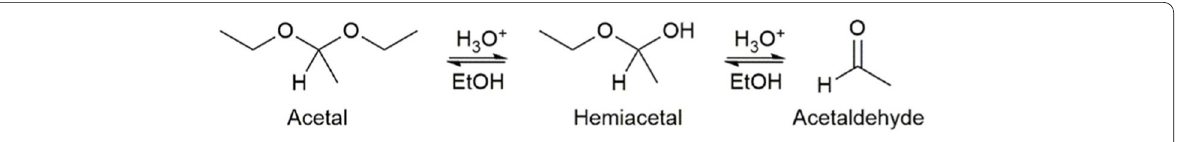
Fig. 1 Reaction linking acetal and